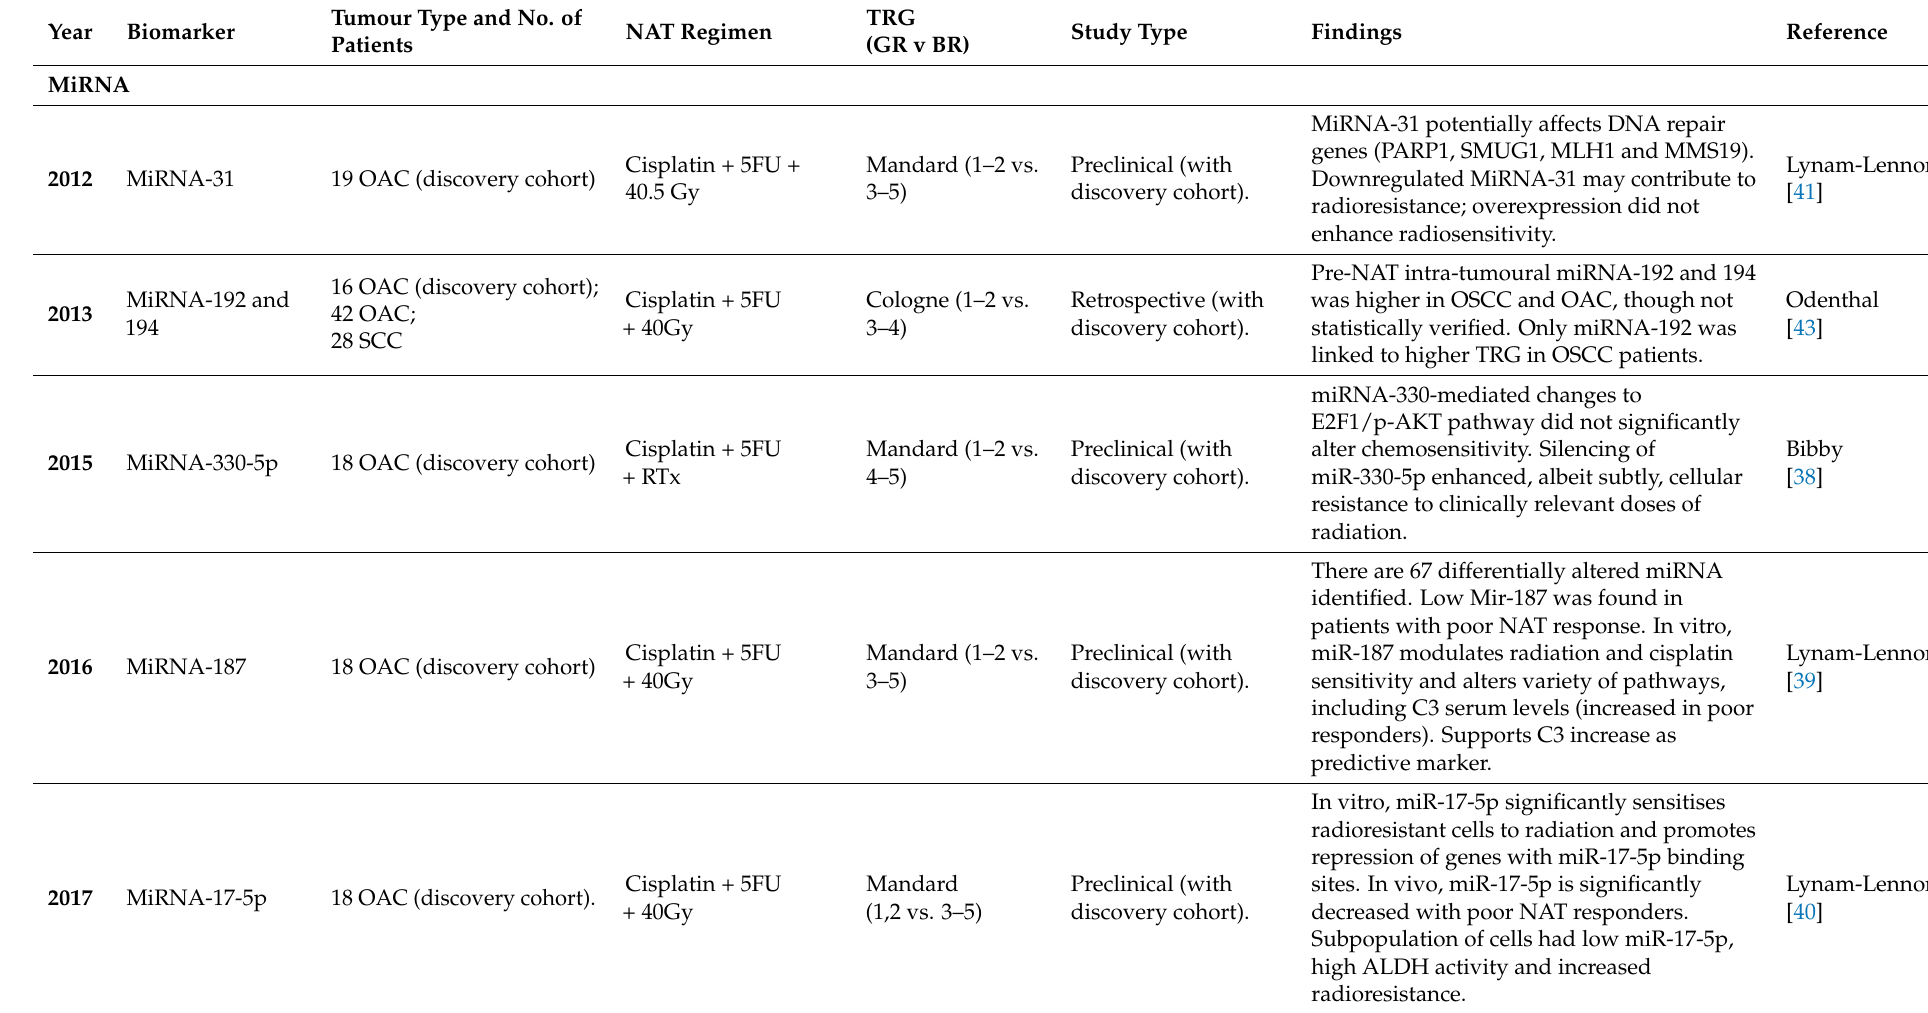
Table A2. Epigenetic